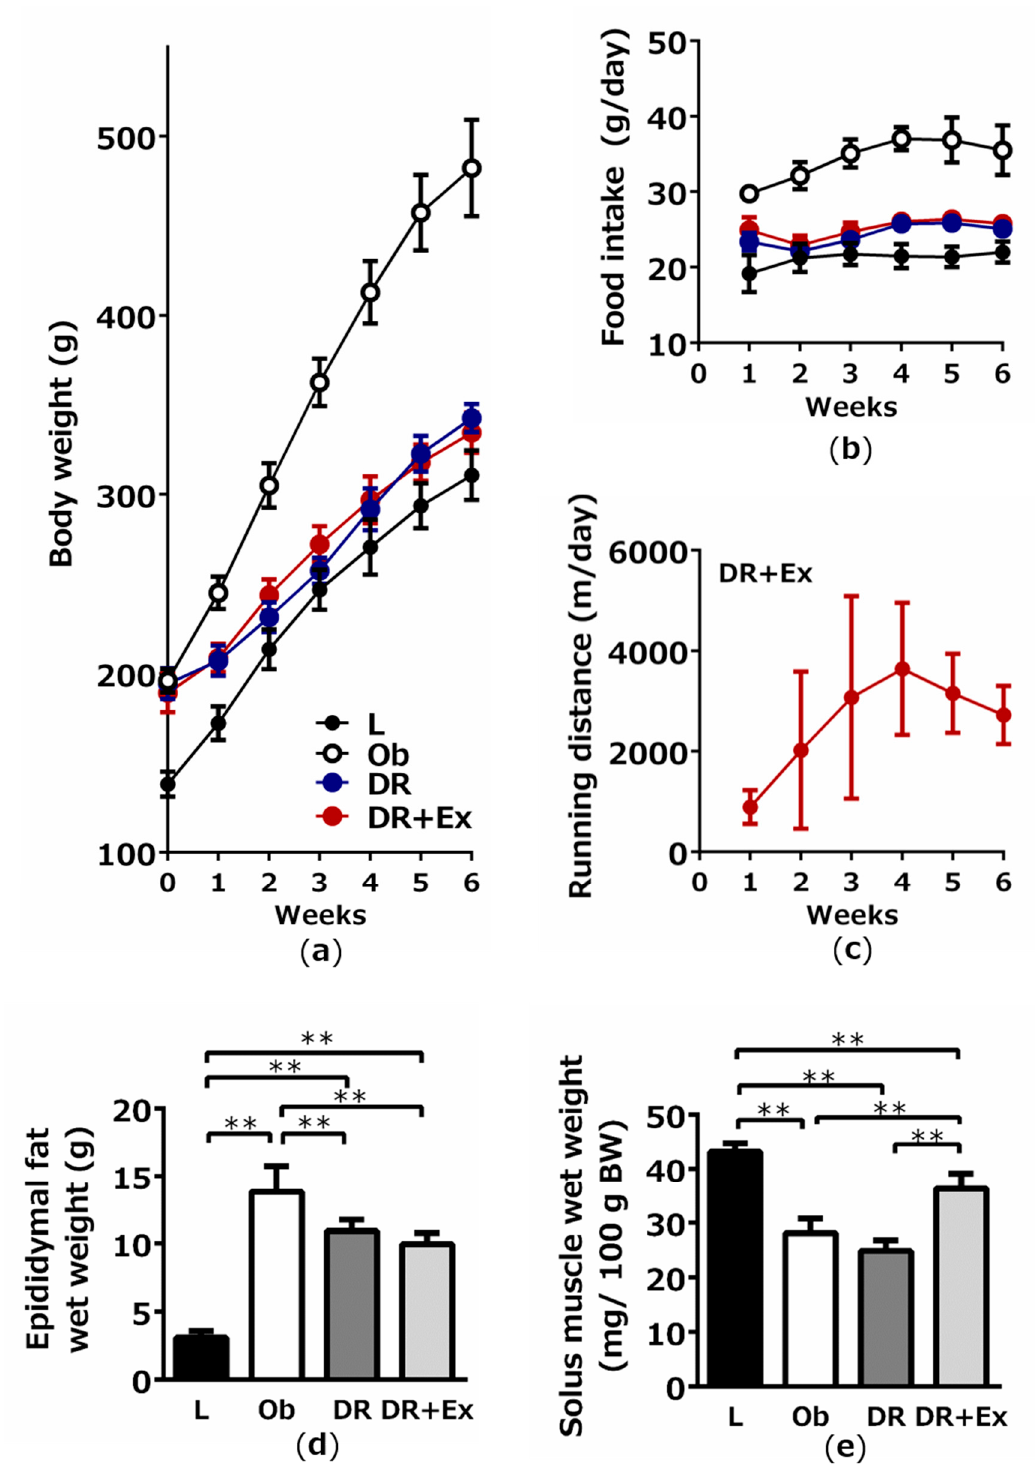
Figure 1. Changes in bodyweight ( a ), food intake ( b ), and running distance ( c ) during the experimental period, and final epididymal fat weight ( d ), and solus muscle weight ( e ) in lean control (L), obese (Ob), dietary restriction (DR), and dietary restriction plus exercise (DR + Ex) groups. The weight gain and fat weight were greater in the Ob group and lower in the DR and DR + Ex groups. Although rats in the DR and DR + Ex groups consumed the same amount of food, and only the DR + Ex group performed exercise ( c ), there was no significant difference in body weight between the DR and DR + Ex groups. Values are the means ± SDs ( n = 6 rats in each group). ** p < 0.01.